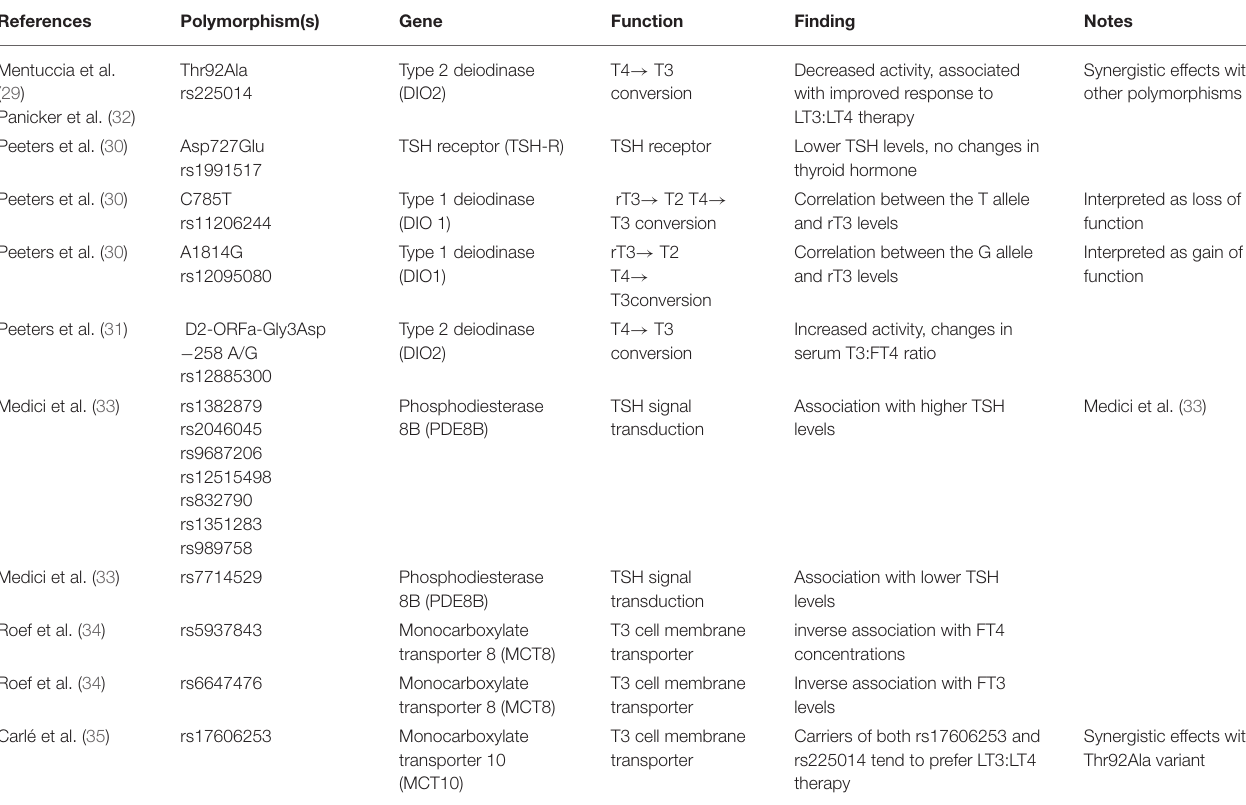
TABLE 2 | Common genetic polymorphisms (Single Nucleotide Polymorphisms-SNP) associated with thyroid hormone axis and response to